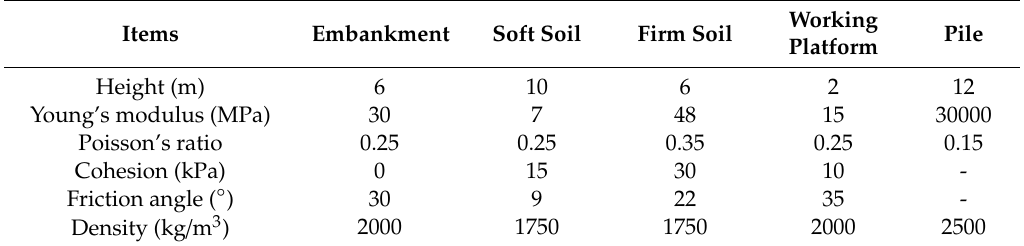
Figure 6. The numerical model: ( a ) the unit cell of the pile supported embankment, ( b ) the profile of the pile with a conical head, ( c ) the profile of the equal section pile. Table 1. Material properties and geometric parameters used in the numerical